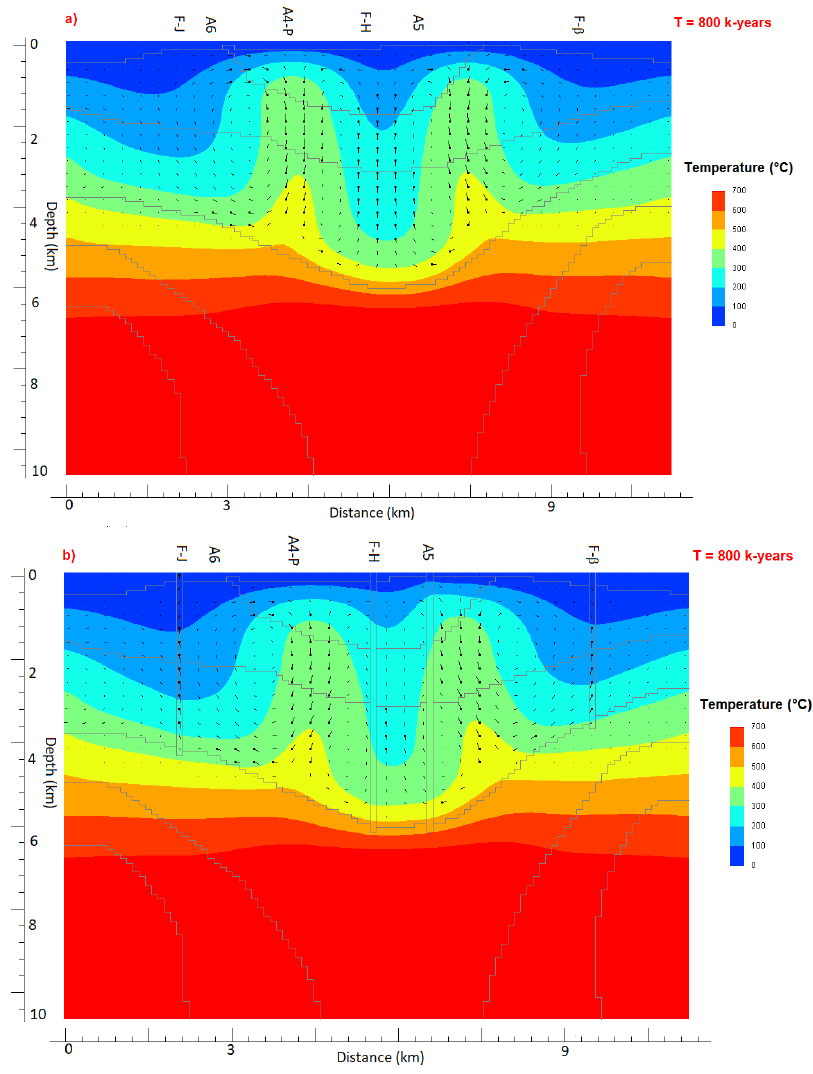
Figure 3. Simulated temperature and flow vectors at time 800,000 years for ( a ) scenario 1 and ( b ) scenario 2A. The direction of flow is from the point to the end of straight lines. The length of each line indicates the flow vector magnitude, where 1.2 km = 10 −6 g s −1 cm −2 . The cold downflow is toward the center of the C3 layer, and due to the temperature increase, the flow direction reverses and the hot upflow circulates toward the overlying units and migrates according to the development of the high-temperature zones. When considering the presence of faults (scenario 2A), there is less cold downflow at the center between faults H and F than in scenario 1 without faults, but the outermost faults (F-J and F- β ) act as a preferred path for the downflow circulation. In scenario 3 (Figure 4), the hot upflow takes place along fault H, whereas faults F-J and F- β exhibit a preferred path for the downflow circulation. Additionally, fault F (A5) experiences a mixture of cold and relatively hot downflow. In scenario 4 (Figure 4), the pattern of flow is similar to scenario 2A, but between faults F and β , the hot upflow circulates toward the northeast direction (toward fault β ), and the system at the center of the rift is hotter between faults H and F where a hot upflow replaces the downflow when compared to scenario 3. In scenarios 5A and 6A (Figure 5), lateral flow is more pronounced than for the preceding simulations due to the increased horizontal permeability. Moreover, the direction of flow is different in each layer (C2 and C3; Figure 2) and inside the fault systems. At the center of the rift in the C2 layer, the hot upflow is toward the rift margins (toward the northeast and southwest) direction, while the downflow originates from the rift margins and is toward the center of the rift. There is a significant lateral flow toward the rift center in the C3 layer, while the hot upflow is directed vertically toward the C2 layer and is concentrated inside the 300 – 400 °C isotherms. Furthermore, the flow vectors inside the faults show two different patterns in scenario 5A. The first pattern is a dominant downflow circulation inside the outermost faults (F-J and F- β ), whereas the second pattern illustrates upflow and discharge and is localized in the upper part of the faults (F-J and F- β ) close to the surface (Figure 5). For this same simulation scenario 5A, fault H (F-H) does not seem to act as a preferred path for fluid flow while there is an important hot upflow taking place along the fault F (F-F). In scenario 6A, significant lateral and vertical flow co-exist in the C3 unit. At the center of the rift, there is a hot and wide zone with significant oblique upflow (azimuthal direction). Each hot upflow area is surrounded by cold downflow areas, but lateral flow toward the center of the rift also exists, particularly inside the C3 layer.